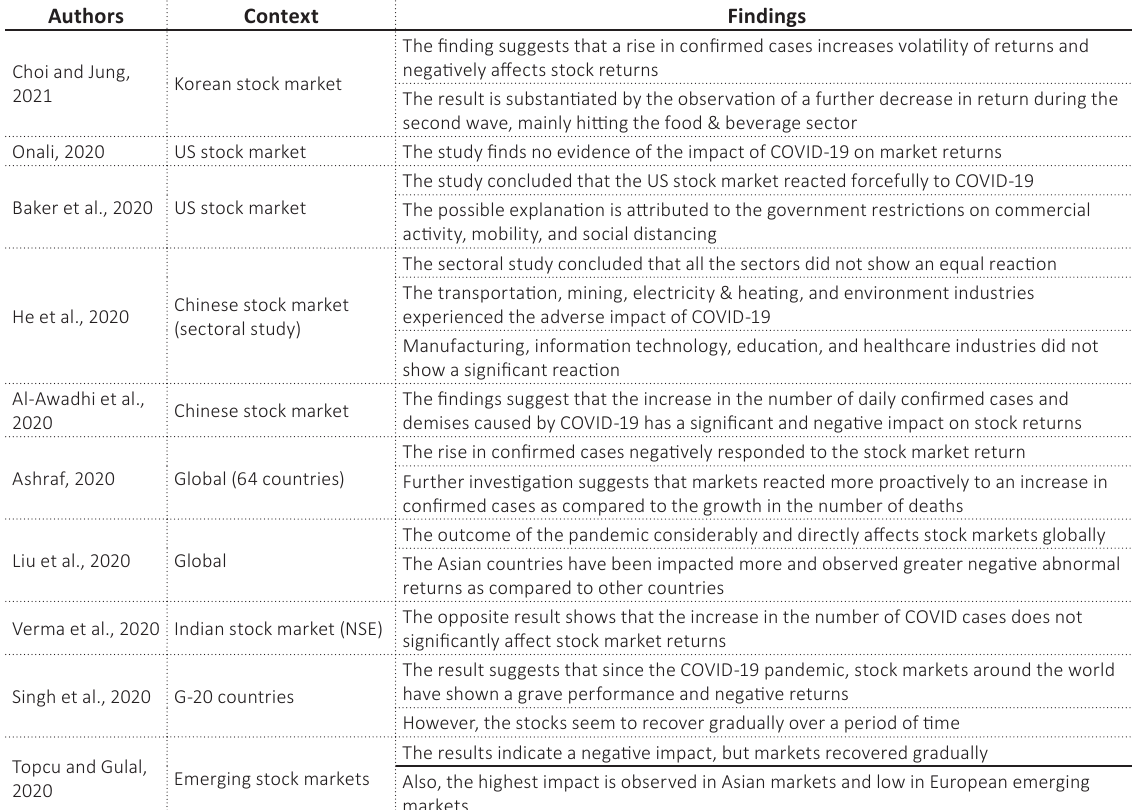
Table 1. Recent research on the impact of COVID-19 on stock